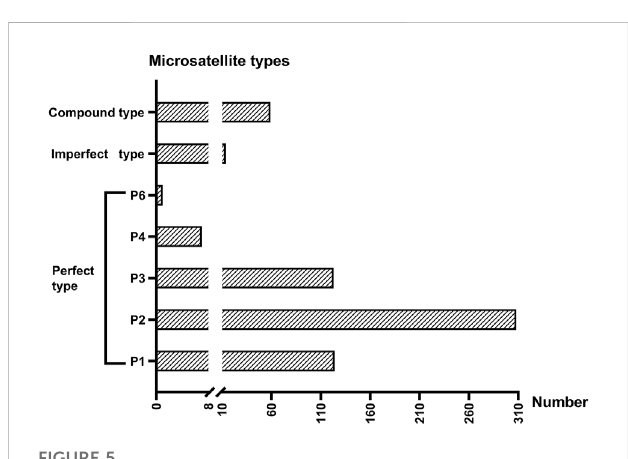
FIGURE 5 The number of three microsatellites types gained from six thelytokous D. wani . P1 ~ P4 and P6 represent mono-, di-, tri-, tetra-, and hexanucleotide repeats of perfect